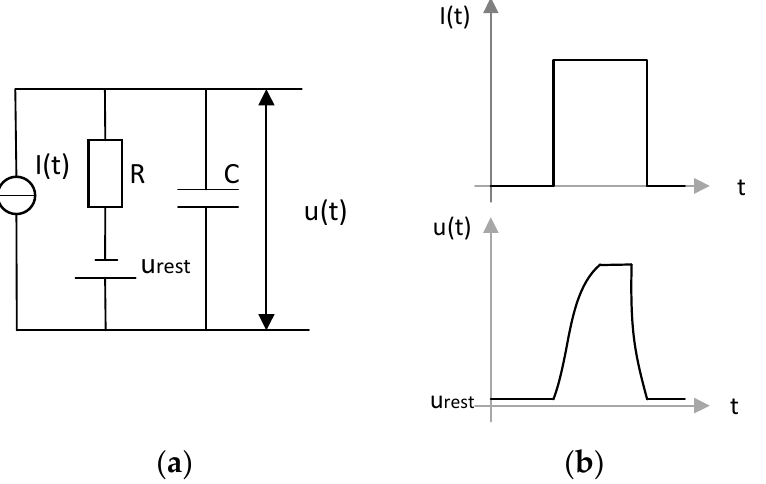
Figure 4. LIF Model . ( a ) RC circuit; ( b ) relationship of U and I. Figure 4. LIF Model. ( a ) RC circuit; ( b ) relationship of U and